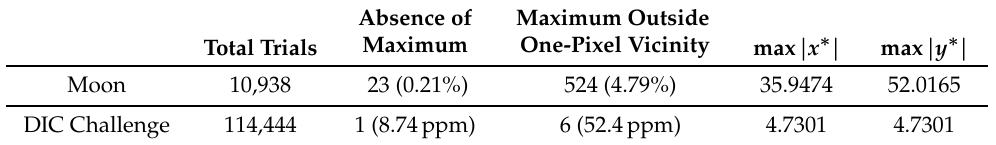
Table 1. Original QSF method failure occurrences in the Moon and DIC Challenge examples. Total trials: number of total trials of the QSF method. Absence of maximum: number of trials yielding a saddle point (and in percentage of total trials). Maximum outside the one-pixel vicinity: number of trials yielding a maximum of the fitted surface located at ( x ∗ , y ∗ ) with | x ∗ | > 1 or | y ∗ | > 1 (and ppm, part per million). max | x ∗ | : the maximum value of | x ∗ | among all the trials. max | y ∗ | : the maximum value of | y ∗ | among all the trials. Absence Total Trials